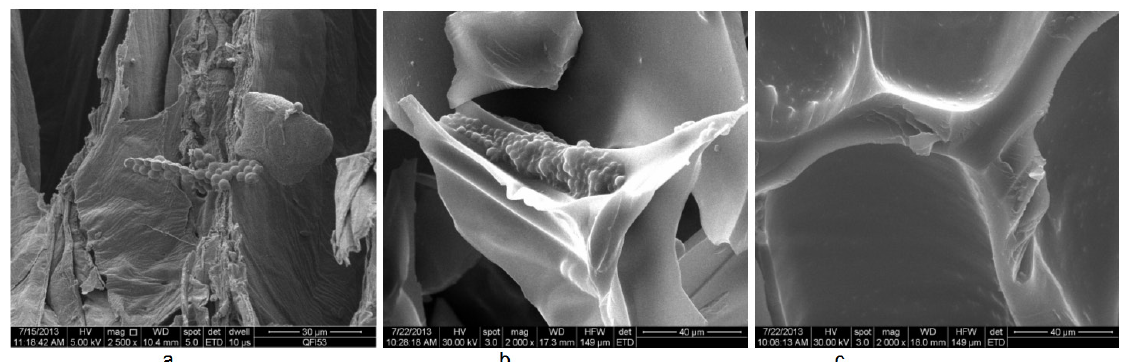
Figure 2. SEM cross-section images for structures on which the yeast developed for 3 days: a) MSS; b) HEMA-PAAm; c) PAAm.